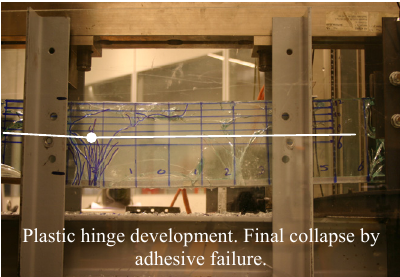
Figure 6: A more complex system involving overlapping glass segments and shear loads,